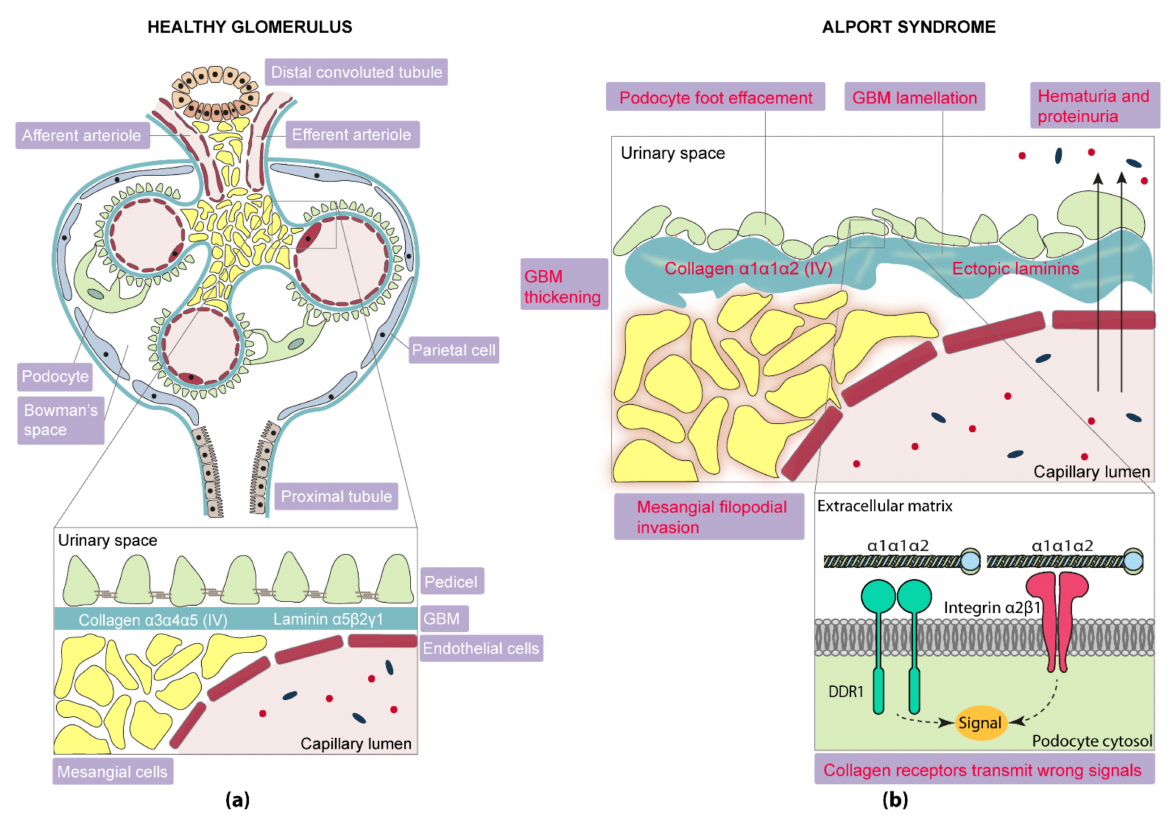
Figure 3. Graphic representation of the renal glomerulus and detail of the glomerular filtration barrier. ( a ) Healthy glomerulus presents podocyte foot processes with slit diaphragms. The mature GBM is composed of collagen α 3 α 4 α 5 and laminin α 5 β 2 γ 1. Albumin does not filtrate pathologically into the urinary space. ( b ) In Alport glomerulus, podocyte foot effacement disrupts the podocyte structure and slit diaphragms disappear. Immature forms of collagen and laminins are expressed in the GBM as a compensatory mechanism. Albumin is lost pathologically due to increased